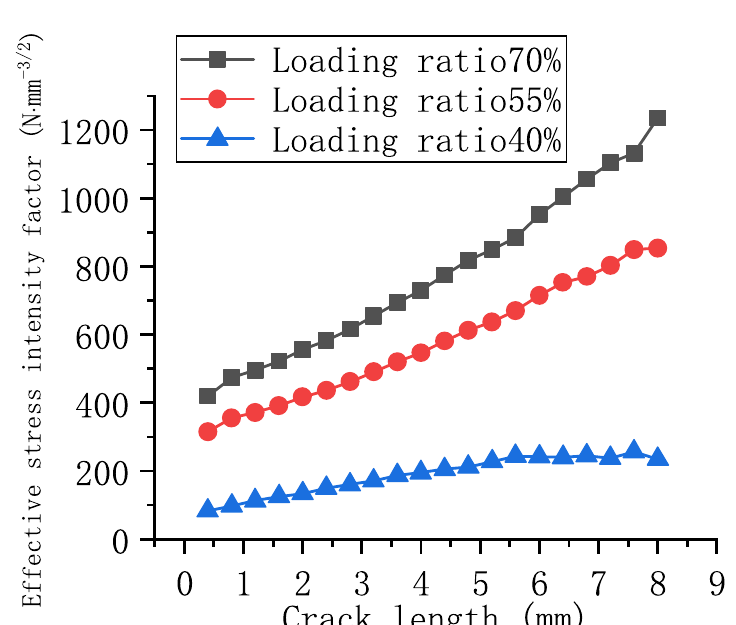
Fig. 15 Effective stress intensity factor range